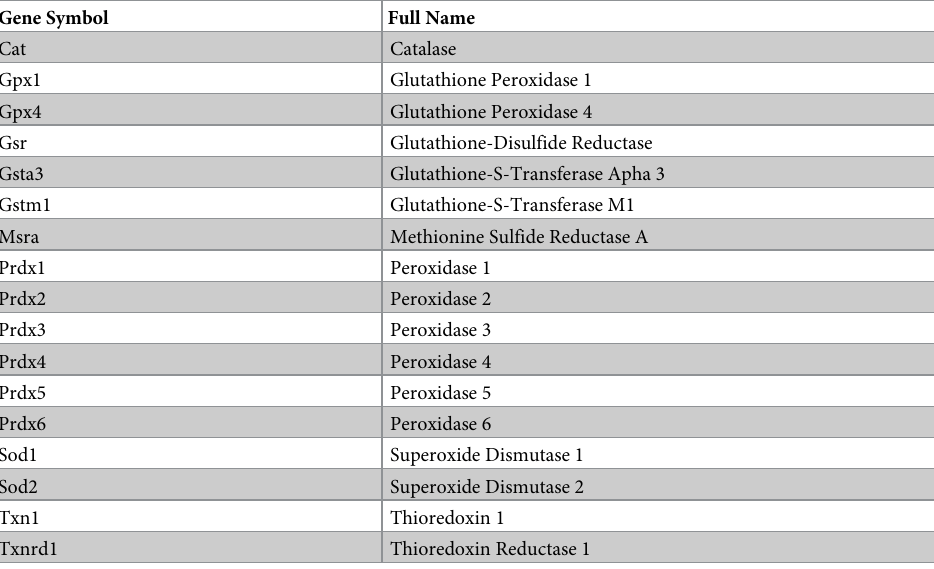
Table 1. Full names of genes presented in Fig 7. Gene